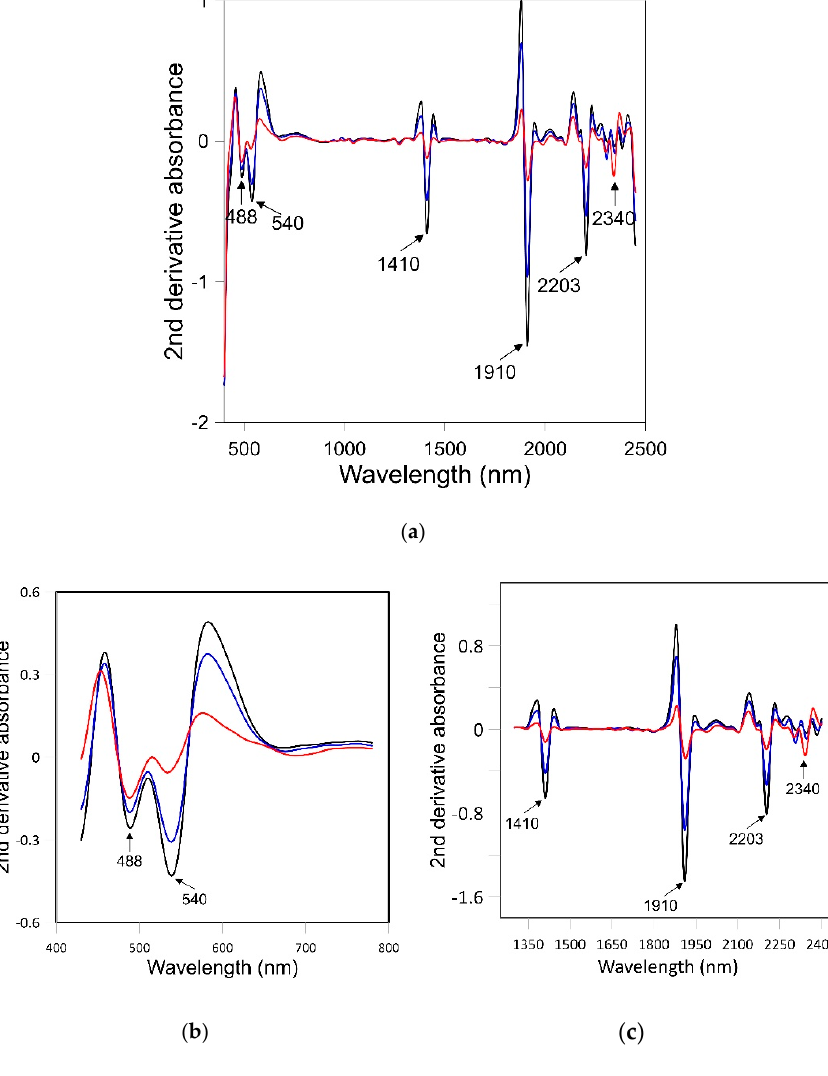
Figure 5. Average second derivative of absorbance (A = log 1/R) spectra ( a ) and its magnification in two significant ranges of visible ( b ) and near-infrared ( c ) region of soils from the three clusters In the NIR, in particular at longer wavelengths, beyond 1300 nm, many depth ab- sorption features are due to clay minerals [24], due to overtones and combination modes of the fundamental vibrations of functional groups that occur in the mid-infrared region